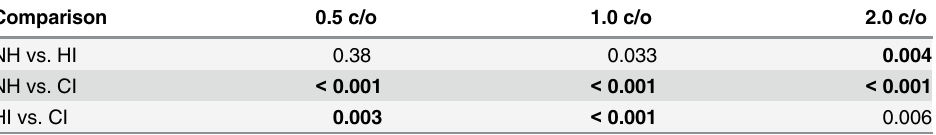
Table 3. Results for post hoc independent samples t-tests on the STM detection thresholds collapsed across two temporal modulation rates. For each comparison, p -values are reported. Bold values indicate a significant difference after applying a Bonferroni